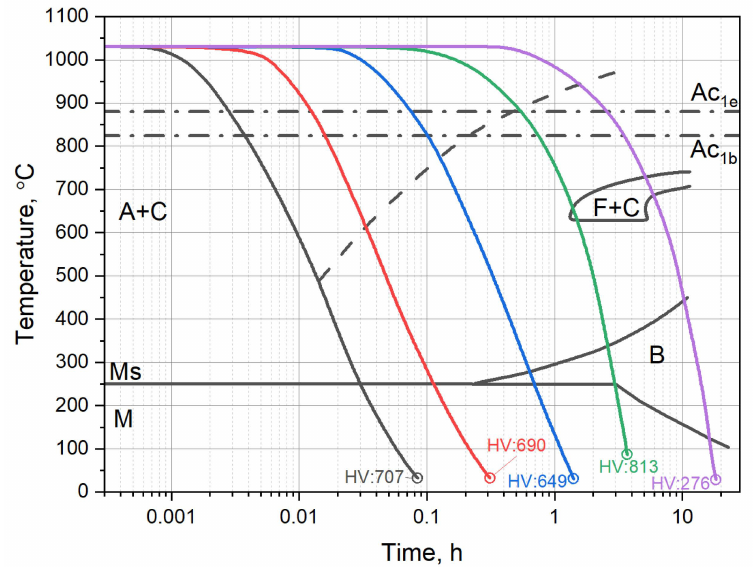
Figure 1. TTT curves (together with Continuous Cooling Transformation (CCT) curves) correspond- ing to the start of the precipitation of various phases in X37CrMoV5-1 hot-work tool steel; the letters stand for austenite (A), cementite (C), martensite (M), bainite (B), martensite start temperature (M S ), ferrite (F) and austenite transformation temperature (Ac 1e —start and Ac 1b —end temperature of austenite transformation) [24].